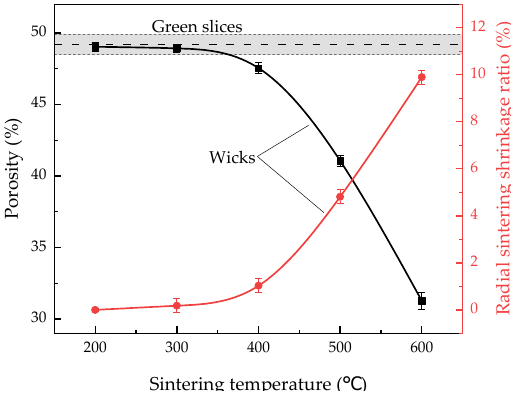
Figure 2. Radial shrinkage and porosity of green slices and wicks sintered at different temperatures. Grain-boundary diffusion dominates in the sintering shrinkage of wicks in the pres- ence of low temperatures and small particle diameters [28]. The sintering shrinkage of